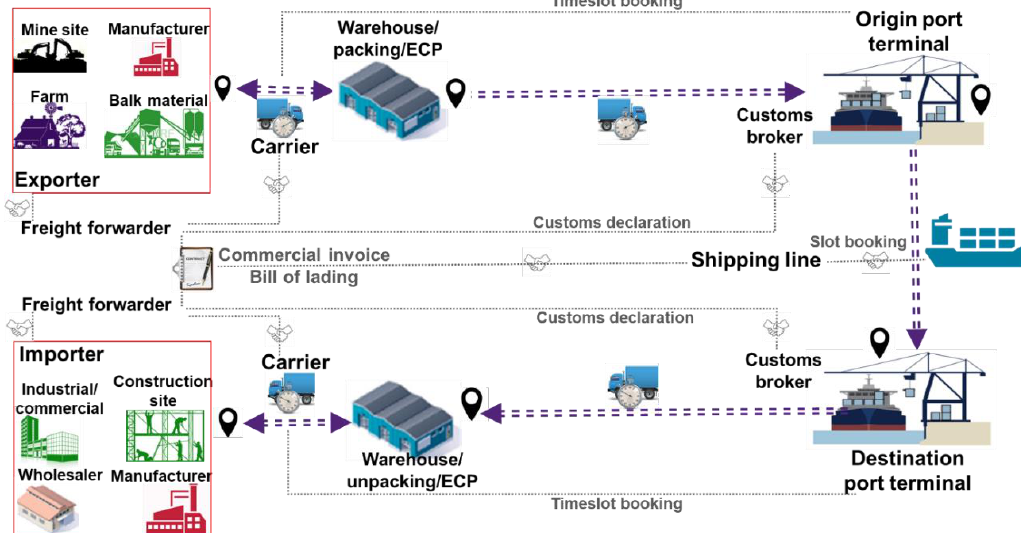
Figure 5. The fragmented market of international freight transportation.